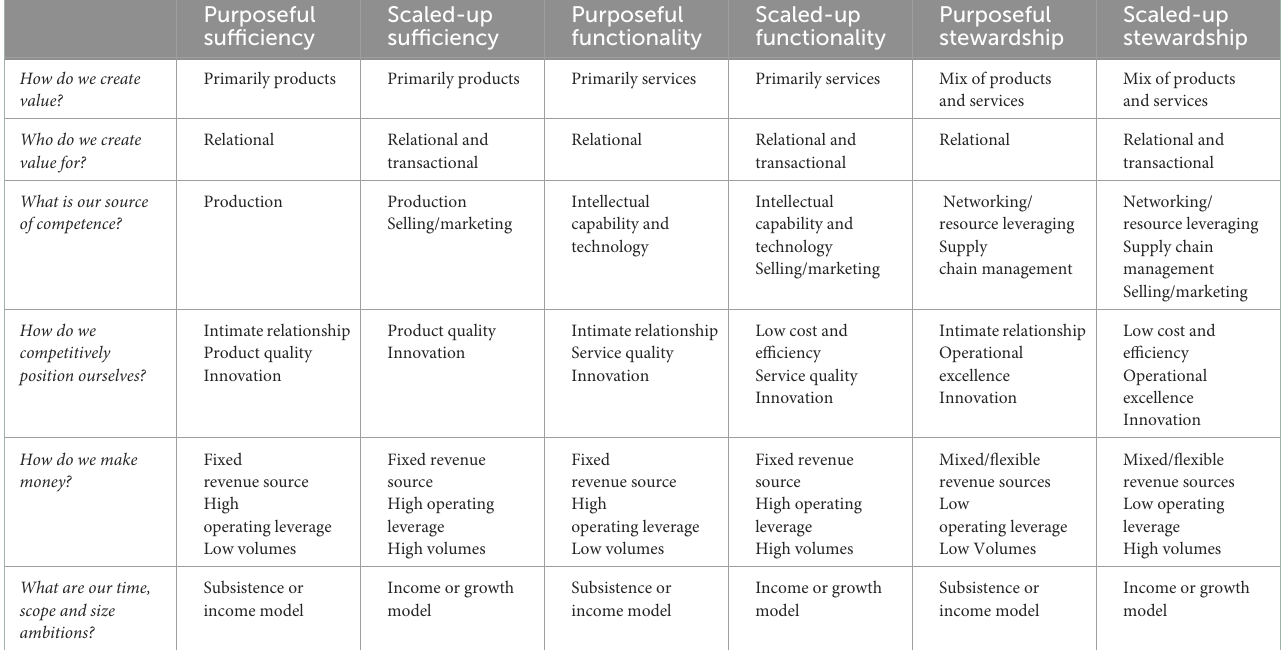
TABLE 1 SCBM’s unraveled using the foundation level of the integrative framework by Morris et al.